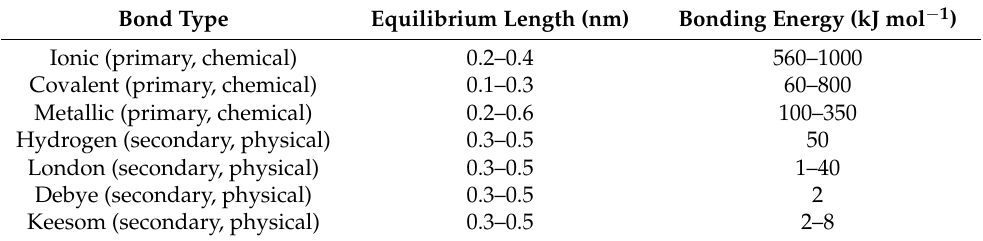
Table 1. Different types of bonds and their range of bonding energy and interaction